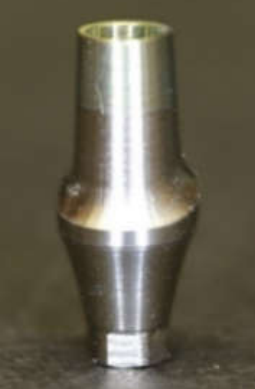
Figure 3. Three groups of zirconia abutments used: All-Zr (a), ASC-Zr (b), and AM-Zr abutments (c).